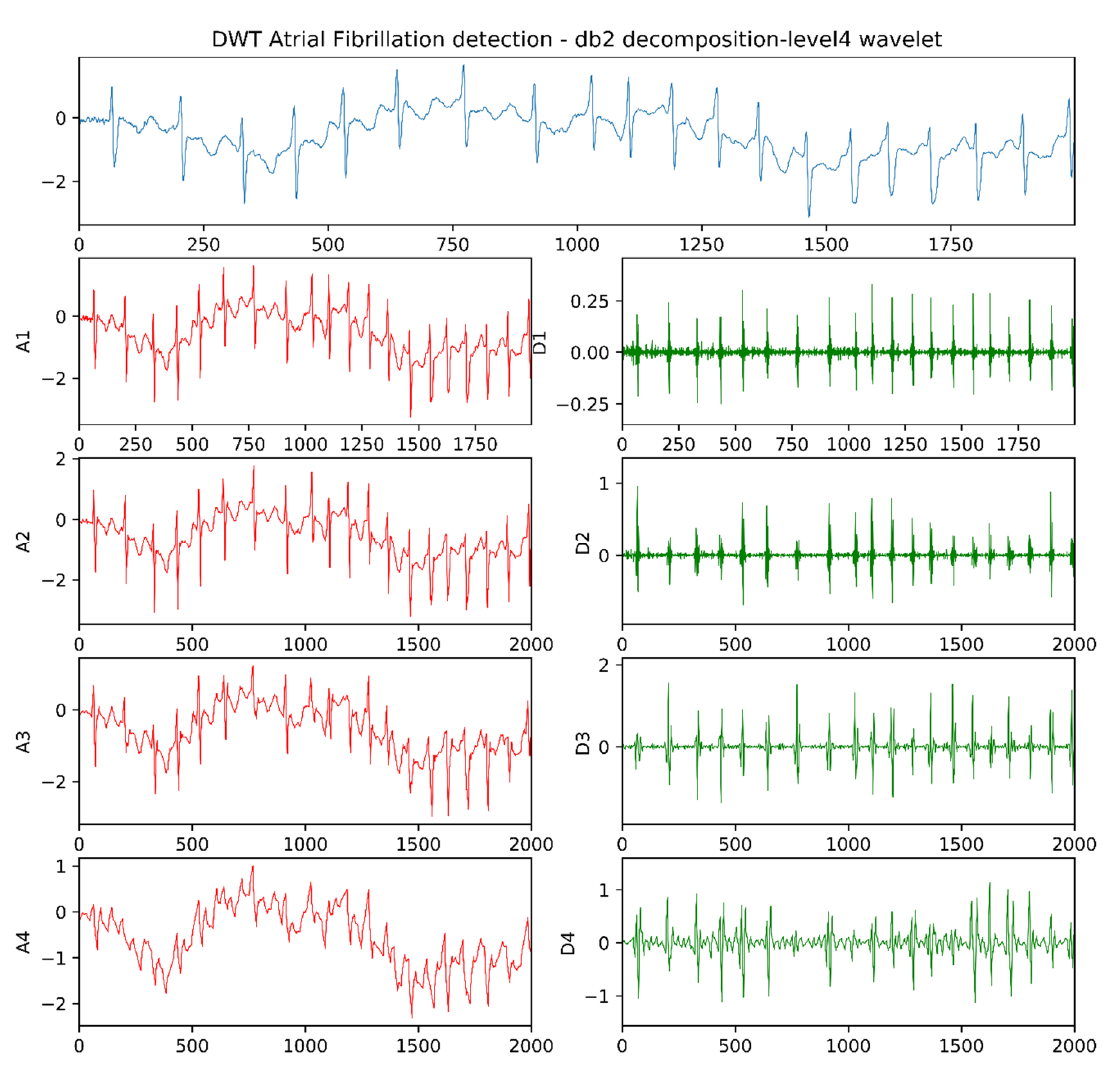
Figure 6. Decomposition Level 4 using DB 2 on the 04015 ECG signal. Red graphs and green graphs are approximate and detailed signals, respectively. Table 3. Max, mean, min, and stdev features (normal).